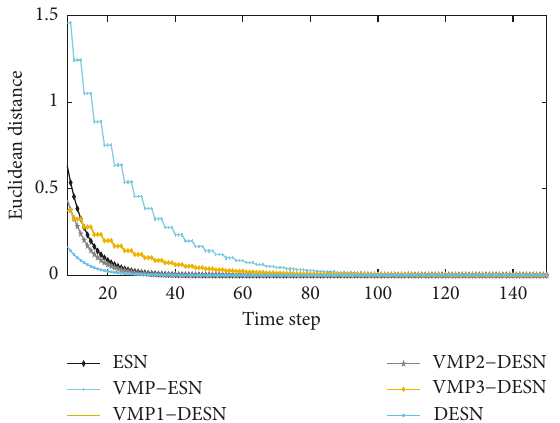
Figure 4: Semilogarithmic Euclidean distance comparison of six prediction models under different input signals.